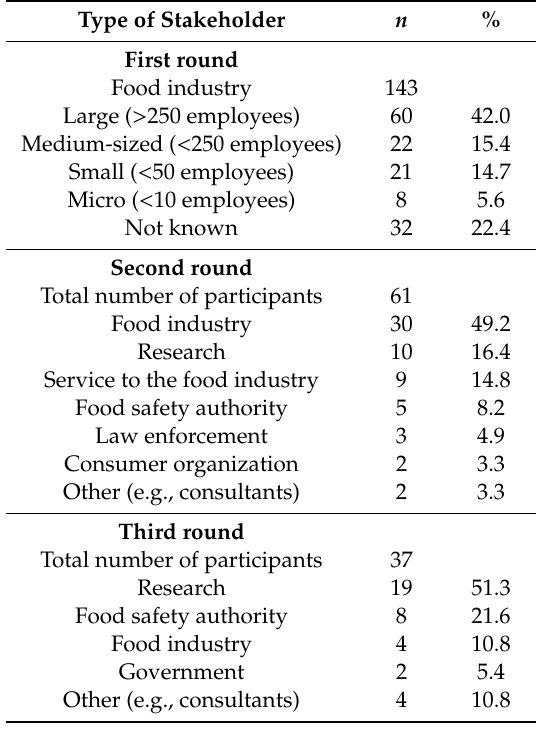
Table 1. Distribution of participating stakeholders in the three rounds of the stakeholder